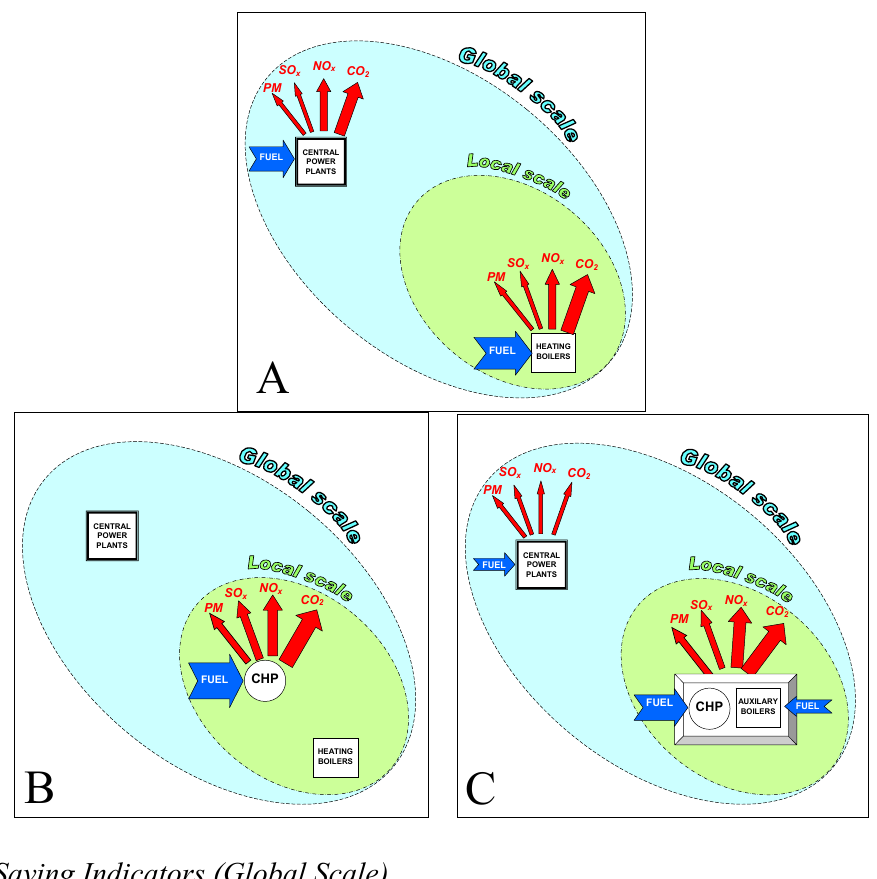
Figure 2. Schematic comparison of the emissions (global and local scale). A : SHP; B : the CHP-unit is matched exactly to the power and heat demands; C : the CHP-unit is not matched exactly to the power and heat demands; a CHP-system (composed of CHP-units, auxiliary boilers, and central power plants) has therefore been